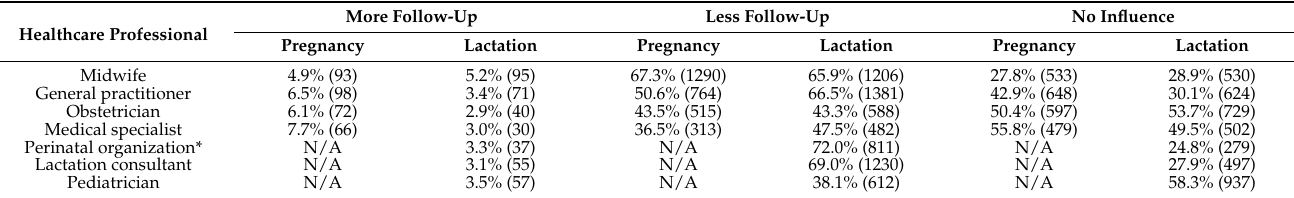
Table 4. Impact of the pandemic on access to health services during pregnancy and lactation ( n = 8709). More Follow-Up Less Follow-Up No Influence Healthcare Professional Pregnancy Lactation Pregnancy Lactation Pregnancy Lactation Midwife 4.9% (93)